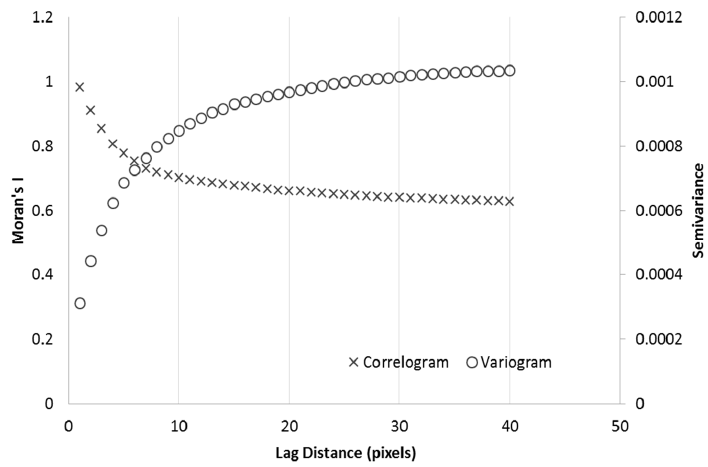
Figure 5. Averaged correlogram and semivariogram plots from the six bands of the 2014 Landsat image, showing the optimal lag distance (~5 pixels) with the highest variance.